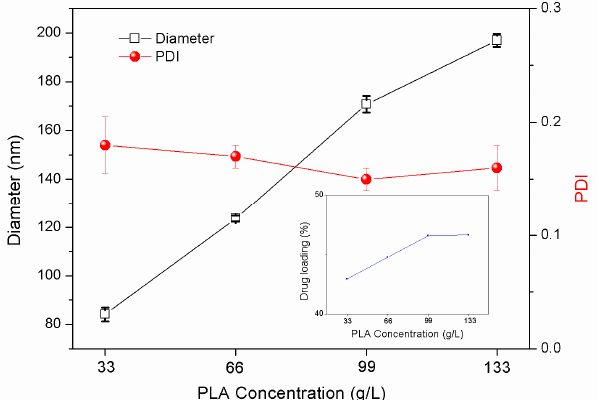
Figure 5. Particle size, size distributions, and LC loading capacities of PLA nanoparticles prepared under different PLA concentrations (PVA concentration was 2%, water–oil ratio was 4:3, and LC-PLA ratio was 1:1).